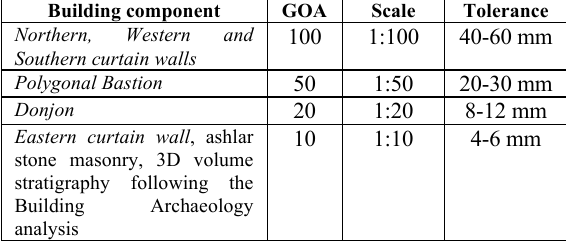
Table 1 . Model scales and GOA for each building component of the